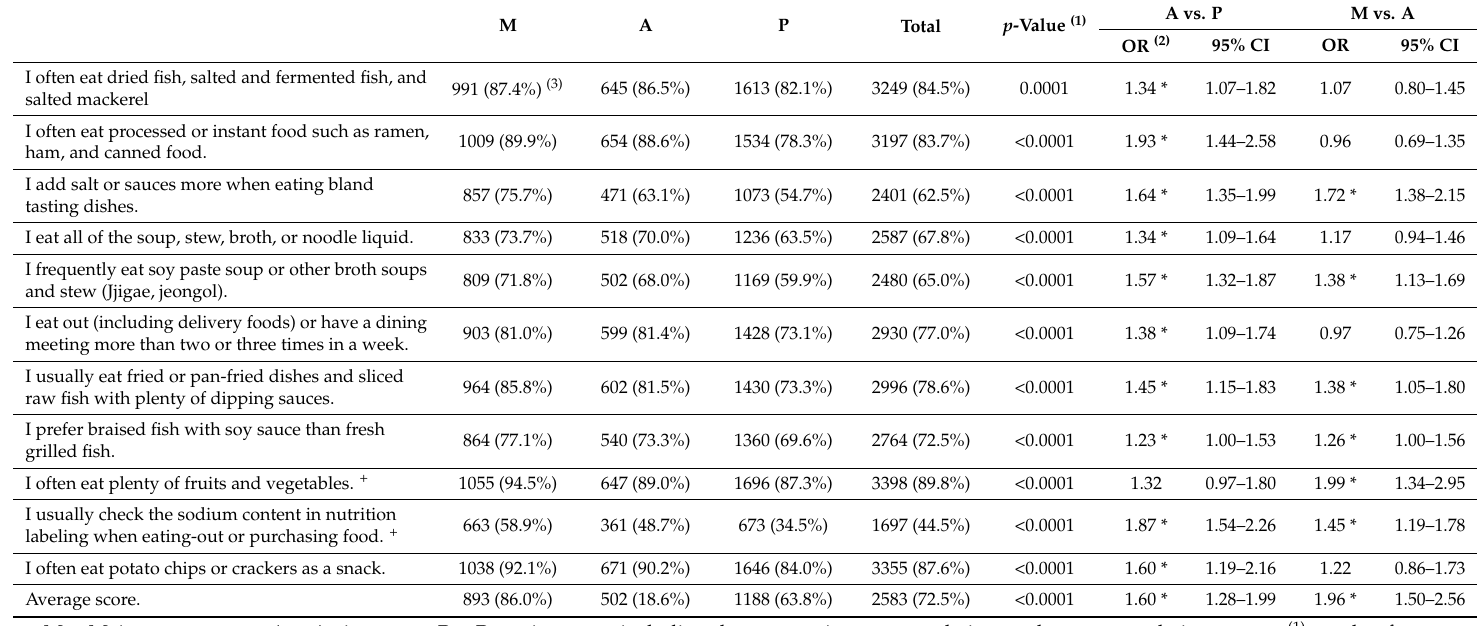
Table 6. Dietary behaviors related to sodium intake according to the stages of